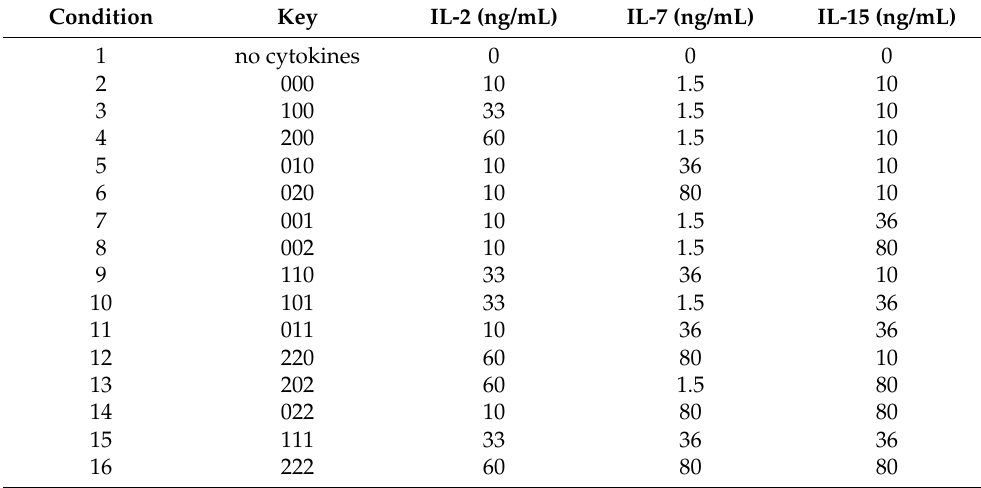
Table 1. The keys and concentrations of IL-2, IL-7, and IL-15 were used in the